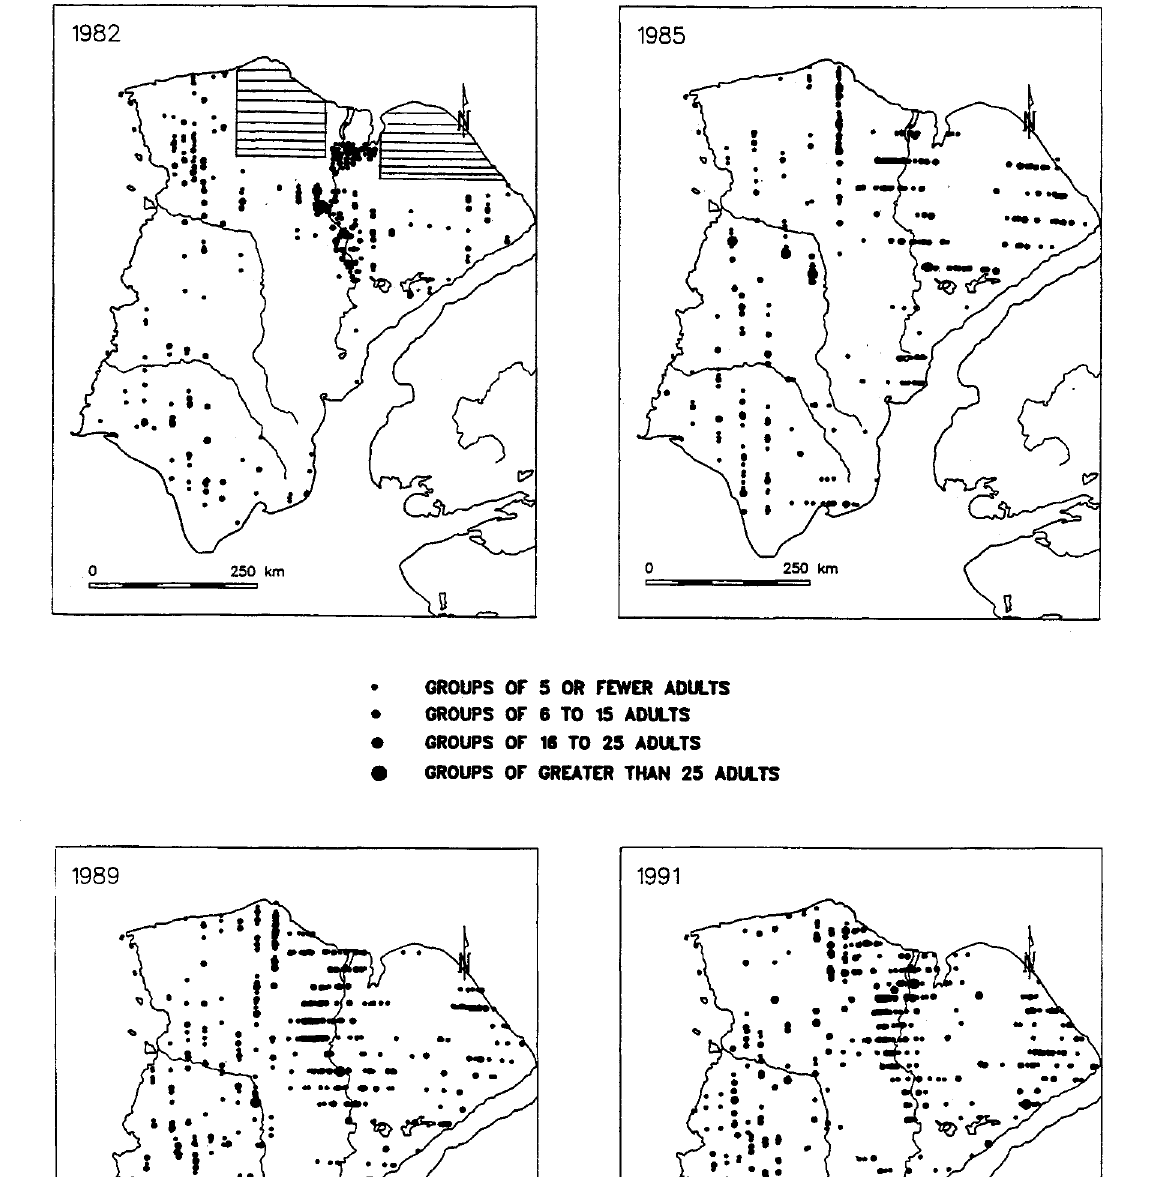
Fig. 5. Changes in distribution of Banks Island muskoxen from 1985 to 1991. The hatched areas on the 1982 map were not surveyed. See fig. 2 for strata